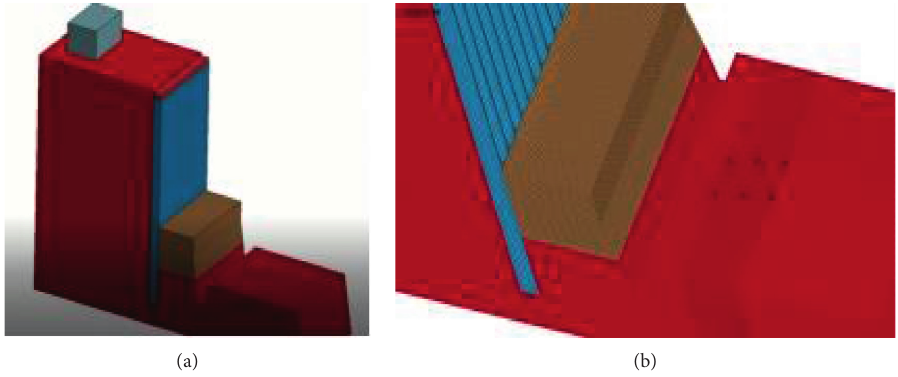
Figure 6: Numerical calculation model: (a) the relative position and (b) mesh